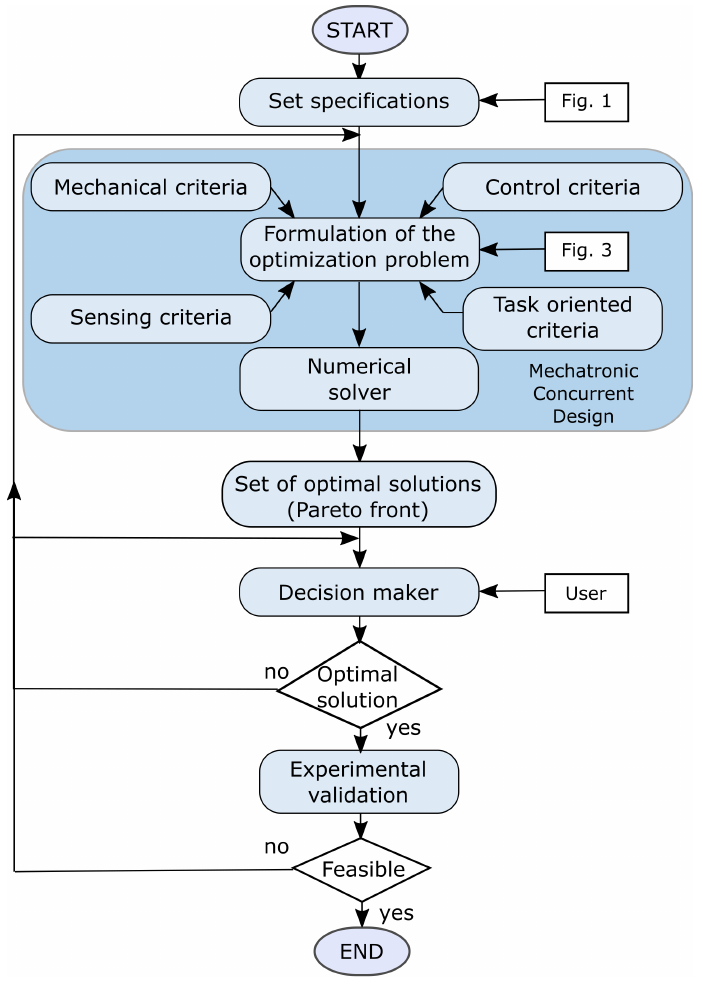
Figure 4. A scheme for a Mechatronic Concurrent Design procedure using concepts in Figures